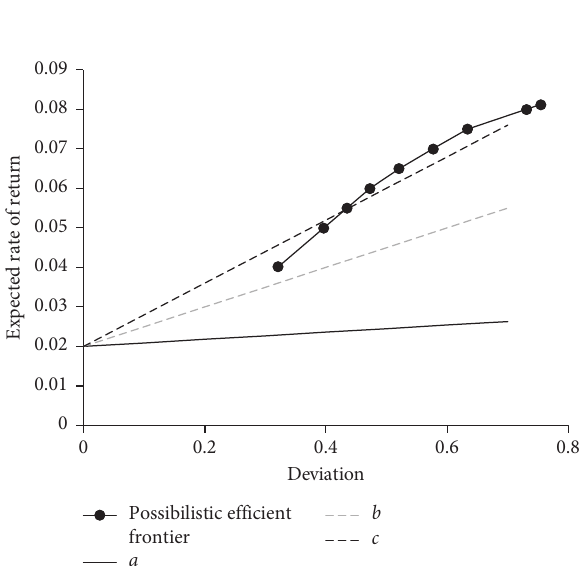
Figure 5: Some possibilistic efficient portfolios with different α